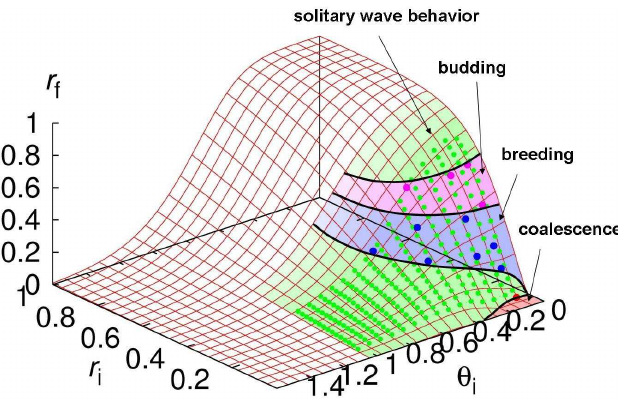
Fig. 7. (Color online) Sketch of the morphological phase diagram for binary collisions. The volume ratio r f after the collision is plot- ted as a function of the initial offset θ i and the initial volume ratio r i . Dots represent simulation results. This figure updates previous simulations of the phase diagram for binary collisions published in Duran et al.